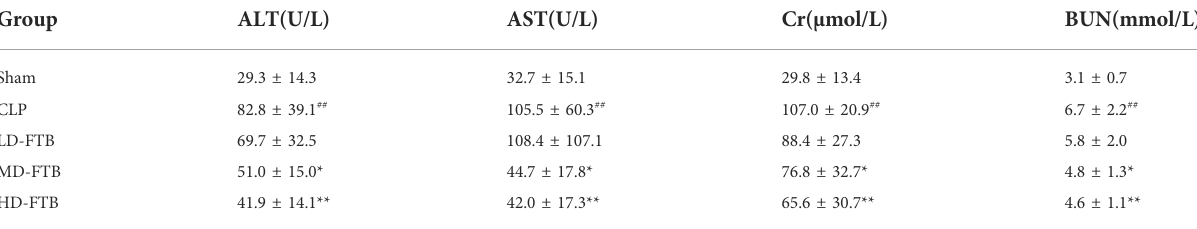
TABLE 1 Changes in ALT and AST activities, Cr and BUN levels after FTB treatment.